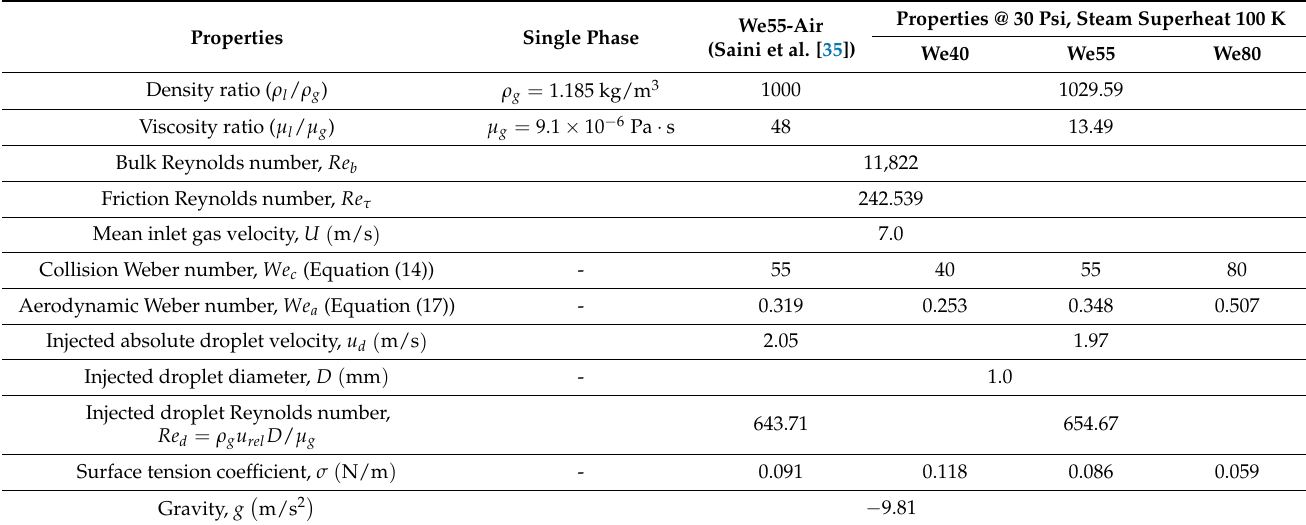
Table 1. Properties for representative dispersed flow film boiling (DFFB) regime